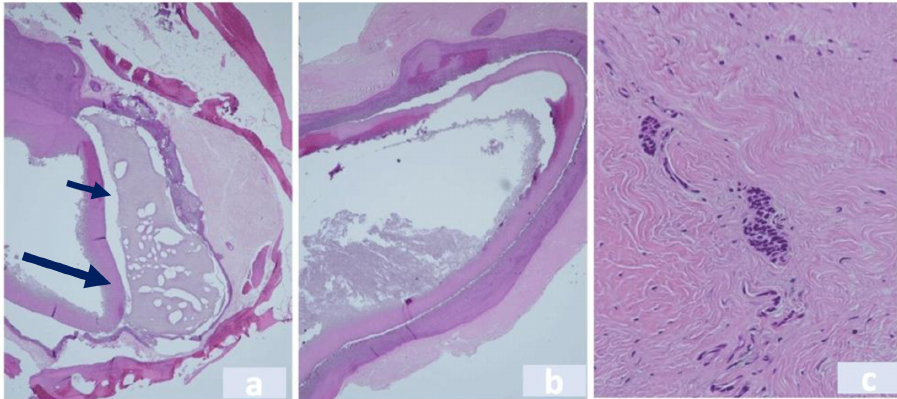
Figure 4. Histopathologic examination of the excised mass showed a tooth-like structure with dentin (long arrow), and enamel matrix (short arrow) confirming the diagnosis of compound odontoma ( Figure 4 a,b). Histological examination for the soft tissue mass showed odontogenic epithelial lamina arranged in islands and cords and surrounded by collagenous connective tissue which confirms the diagnosis of gubernacular tissue (Figure 4c)